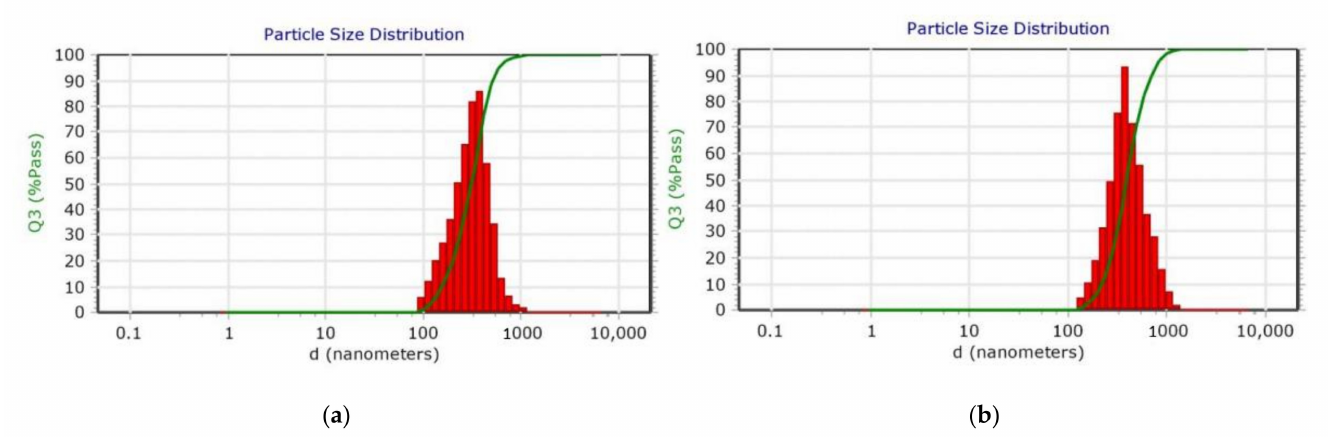
Figure 3. Dynamic light scattering (DLS) particle size distribution of ( a ) PLGA nanoparticles (E10) and ( b ) chitosan-coated PLGA nanoparticles (CS-E10). The graph represents the volume distribution of the nanoparticles, %Volume passing (Q3%pass) vs. diameter ( d